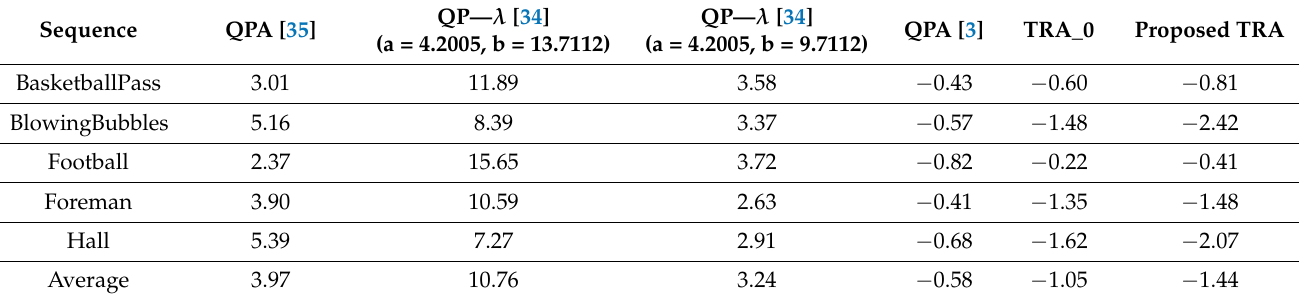
Table 5. Y-BDBR (%) coding performance for TRA and other frame-based